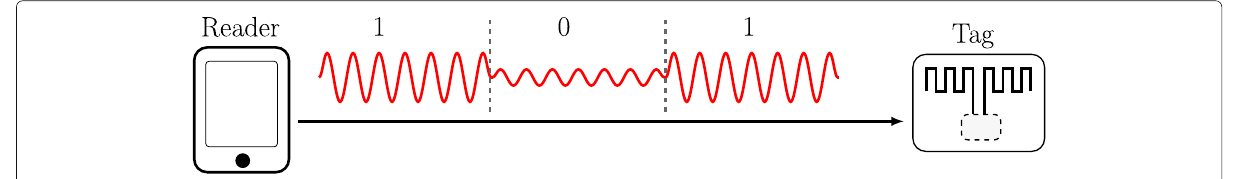
Fig. 2 The forward information-transmission mode of a BackCom